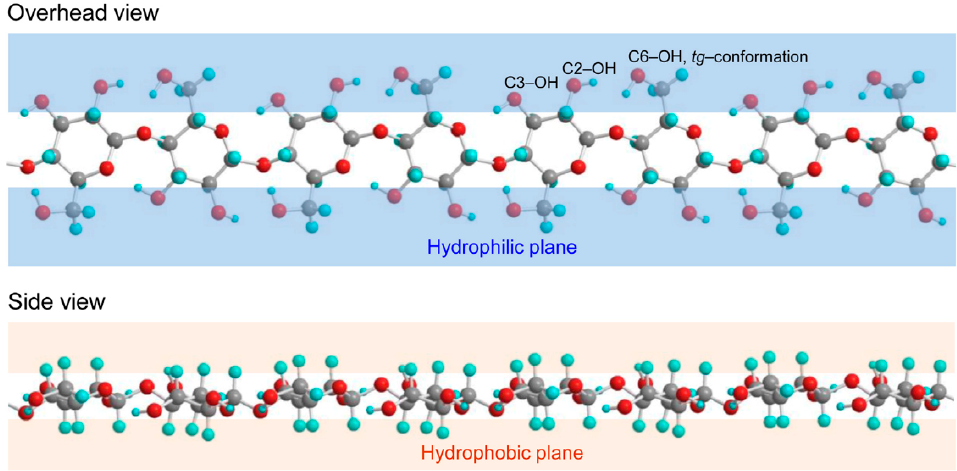
Figure 1. Hydrophilic and hydrophobic planes of cellulose marked with the primary C6-OH (with tg -conformation corresponding cellulose I crystalline structure), and secondary C2-OH and C3-OH groups in glucosyl unit. Reprinted with permission from [37].